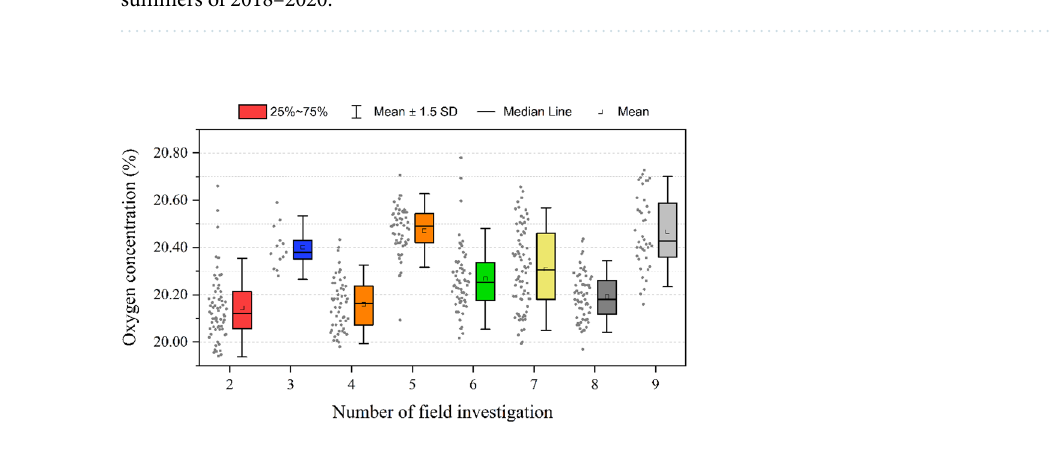
Figure 3. Box plots of oxygen concentration of field investigations during 2018–2020. The numbers of field investigation are the same with those in Table S2 of Supplementary